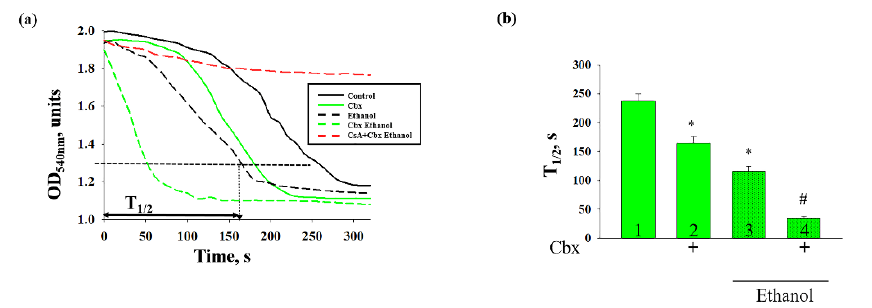
Figure 4. Effect of Cbx on the Ca 2+ -induced swelling of the Control and Ethanol RLM. ( a ) Representative curves of RLM swelling. ( b ) Average half-times (T 1/2 ) of swelling. The values shown are the means ± SD from three independent experiments; * p ≤ 0.05 compared with the control value in the RLM without additions (columns 1); # p ≤ 0.05 compared with the control value in the Ethanol RLM without additions (dotted columns 3).